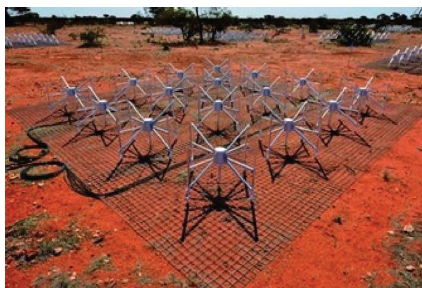
Figure 13: Murchison widefeld array (https://www.mwatelescope. org/).